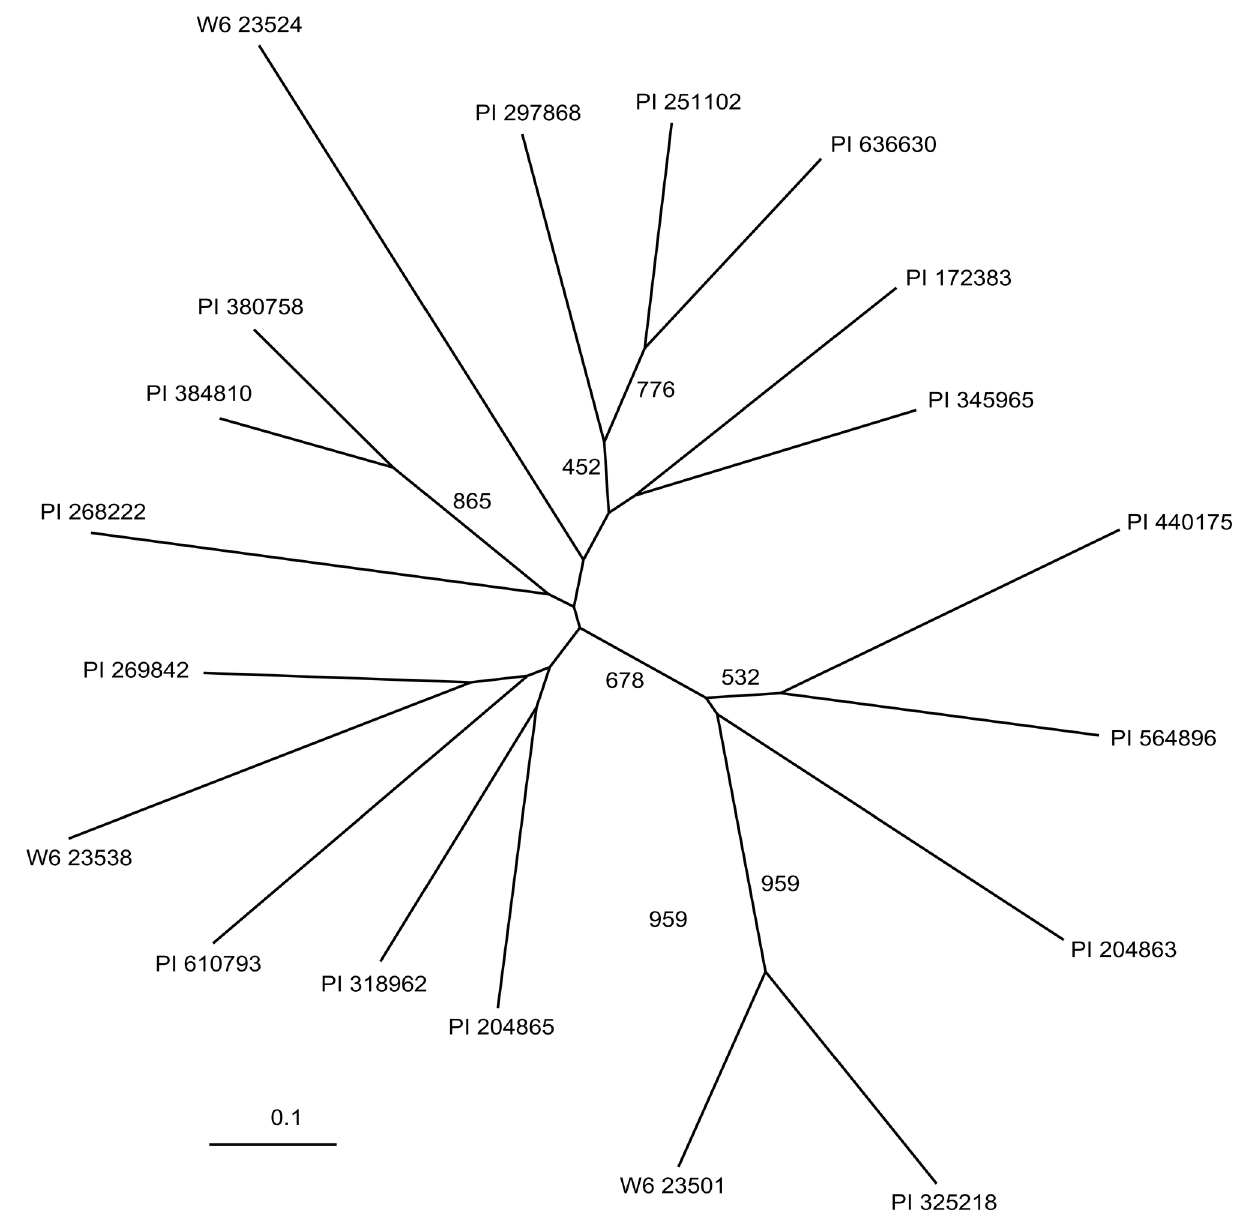
Figure 4. Unrooted neighbor joining consensus tree of 19 lines based on 1,000 shared allele bootstrap trees constructed using 10 SSR markers. Bootstrap values greater than 400 are